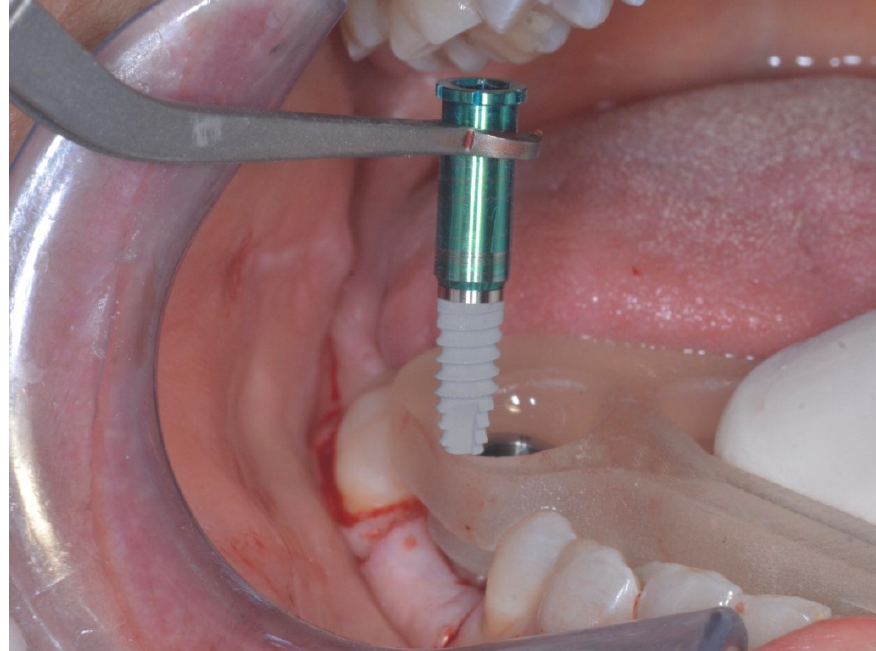
Figure 13. Intraoperative view of the implant fixture, before insertion into the sleeve.